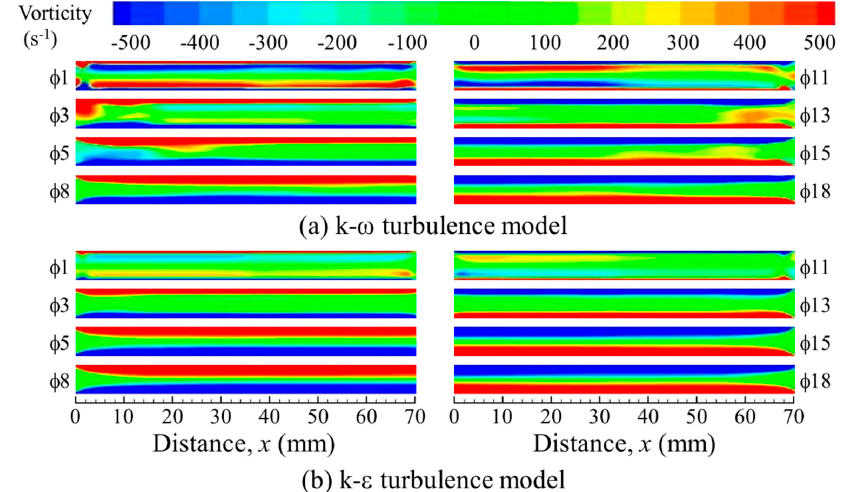
Figure 6. Comparison between vorticity contours from the ( a ) k- ω and ( b ) k- ε turbulence models. The drive ratio is 0.83%. Distance x is measured from the left end of HHX/CHX assembly; vertical axis, y , is omitted for simplicity; the ratio of x : y is